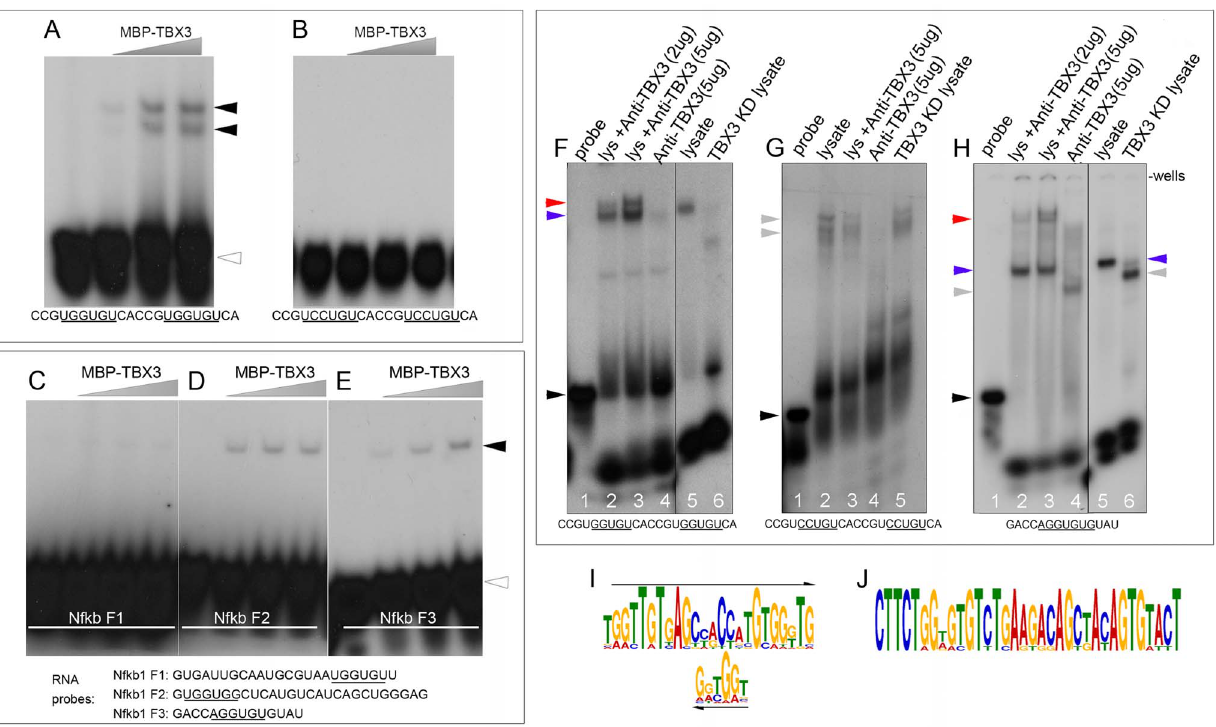
Figure 7. TBX3 binds TBE-containing RNAs directly. A–E) EMSA assays of purified, MBP-conjugated Tbx3 with radiolabeled RNA probes whose sequences are listed at bottom of panels. C–E) RNA probes derived from Nfkb1 intronic fragments (F1–F3). Black arrowheads: probe/protein complex; clear arrowheads: unbound probe. F–H) Shift and supershift RNA EMSA assays of endogenous TBX3; radiolabeled probe sequences are listed below panels. Probes were incubated + / 2 HEK293 lysate, + / 2 anti-TBX3 antibody, + / 2 TBX3 knockdown. F) RNA probe containing GGUGU motifs. Probe/ protein complex (lane 5) supershifts with anti-TBX3 antibody (lanes 2, 3) and disappears with TBX3 knockdown (lane 6). TBX3 + RNA complexes are indicated by blue arrowheads, anti-Tbx3 antibody supershifted TBX3 + RNA complexes are indicated by red arrowheads and unbound probe by black arrowheads. Gray arrowhead indicates probe-protein complexes detected in the absence of TBX3 (lane 6). G) Mutation of the GGUGU to CCUGU results in formation of probe/protein complexes (lane 2) does not supershift with anti-TBX3 antibody (lane 3) and unaffected by TBX3 knockdown (lane 5). H) RNA probe containing AGGUGUG consensus TBE motif from Nfkb1 Fragment 3. Probe/protein complex (lanes 2, 3, 5, blue arrowhead) supershifts with anti-TBX3 antibody (lanes 2, 3, red arrowheads) and decreases with TBX3 knockdown (lane 6). Gray arrowhead indicates probe- protein complexes detected in the absence of TBX3 (lane 6). Probe incubated with no lysate (F–H, lanes 1) or anti-TBX3 antibody alone (F–H, lanes 4) are additional negative controls. IgG negative control EMSAs are shown in Figure S5 G, H. I, J) Significantly over-represented sequence motifs identified by MEME on genomic regions flanking statistically significant AS events contain the 5 9 GGTG T-box core binding element.